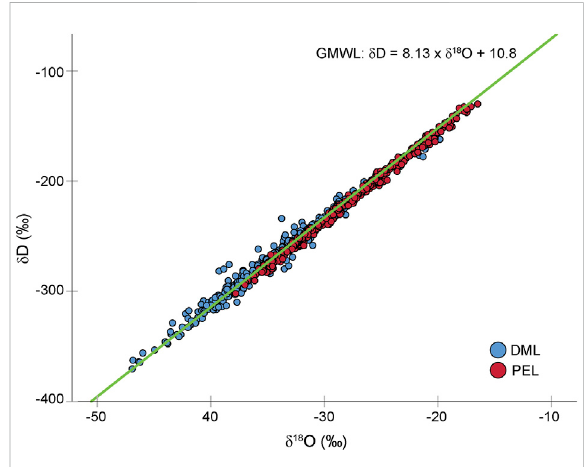
FIGURE 4 Relationship between δ D and δ 18 O in DML and PEL transects. The green line is the Global Meteoric Water Line.